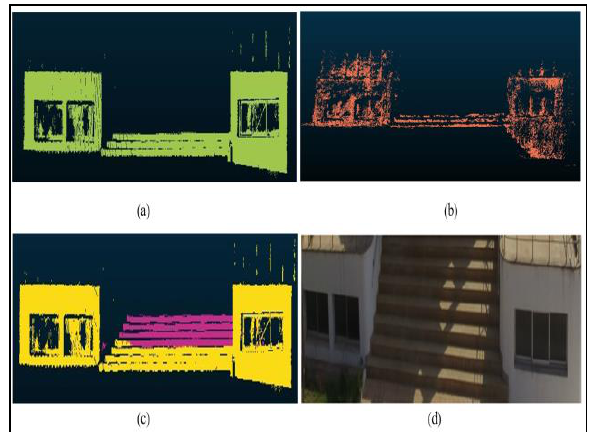
Figure 7 . Extraction of the Stairs at the entrance to the building: (a) from TLS, (b) from Drone, (c) from merged point cloud, (d) origin